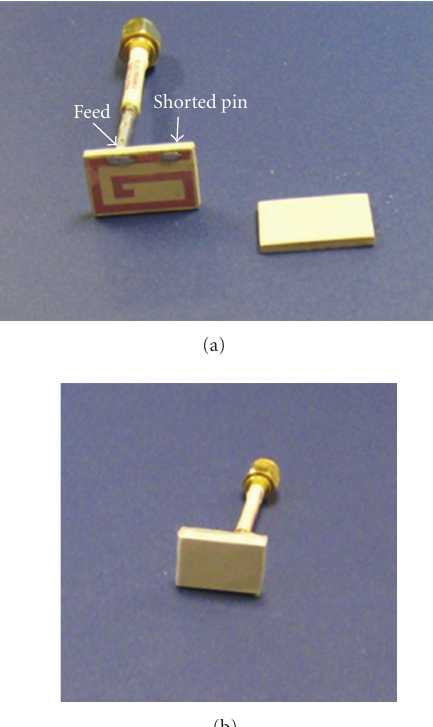
Figure 6: Fabricated embedded spiral-shaped microstrip implant- able antenna: (a) individual pieces, (b) final prototype.